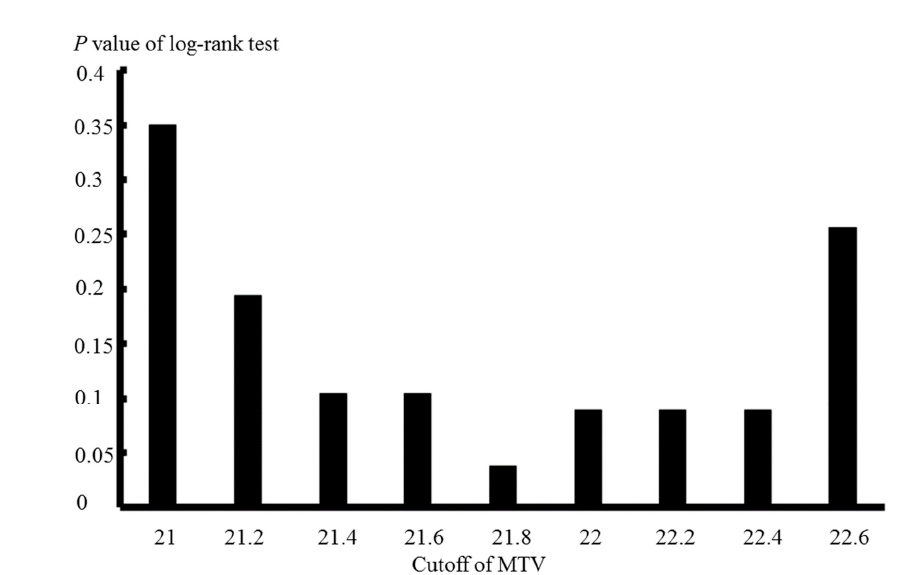
Figure 2. The p values of the log-rank test at dissimilar MTV cut-off values in the sinonasal tract SCC-specific survival analysis from 39 patients. MTV, metabolic tumour volume; SCC, squamous cell carcinoma. The 5-year OS, DFS, LRFS, RRFS and DMFS rates among all patients were 46.2%, 53.9%, 62.6%, 87.0% and 67.9%, respectively. Figure 3 shows the results of the mono- variable survival analyses between MTV ≥ 21.8 and MTV < 21.8. Patients with MTV ≥ 21.8 had a shorter sinonasal tract SCC-specific survival ( p = 0.038), DFS ( p = 0.021) and LRFS ( p = 0.007) than those with MTV < 21.8. No differences between the two groups of MTV were observed in OS ( p = 0.07), RRFS ( p = 0.09) or DMFS ( p = 0.47). Table 2 shows no relationships between MTV and clinical parameters. Table 2. Association between MTV and clinical characteristics in 39 patients. Characteristic